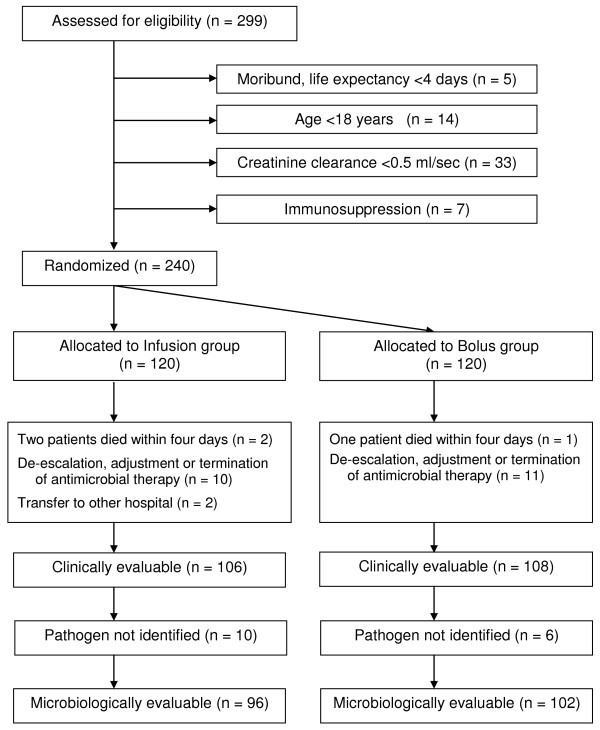
Flow of participants through the trial.